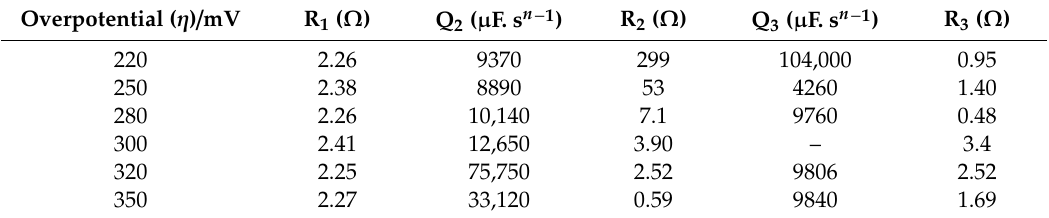
Table 5. The EIS extracted parameters from fitting EIS plots measured at di ff erent overpotential ( η ) of Co 3 O 4 (3) / lsm -TiO 2